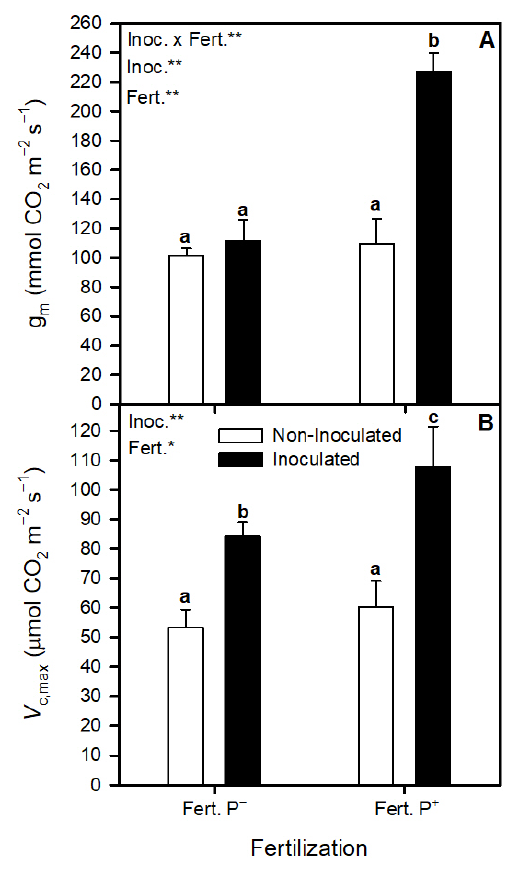
Figure 4. Mesophyll conductance, g m ( A ) and maximum carboxylation rate allowed by RuBP, V c,max ( B ) in strawberry plants fertilized with BNM medium without phosphorus (Fert. P − ) or with BNM medium supplemented with an insoluble phosphorus form (Fert. P+) and subjected to two inocula- tion treatments after 120 days of treatment. Values represent mean ± SE of five replicates. For statis- tical details, see Figure 1 caption. (LSD test, * p < 0.05, ** p < 0.01). Different letters indicate means that are significantly different from each other. F v /F m values were higher in inoculated plants compared to their non-inoculated counterparts, especially in the absence of phosphorus supplementation after 80 and 120 days of treatment (i.e., Fert. P − treatment; GLM: Inoc., p < 0.01; Figure 5A). Furthermore, Φ PSII and ETR values were invariably higher with bacterial inoculation and fertilization with insoluble phosphorus throughout all sampling periods (GLM: Inoc. x Fert., p < 0.05 and p < 0.01; Figure 5B,C). However, there was also a significant positive effect of a lesser magnitude for bacterial inoculation in the absence of phosphorus fertilization after 100 and 120 days (GLM: Inoc., p < 0.01; Figure 5B,C).